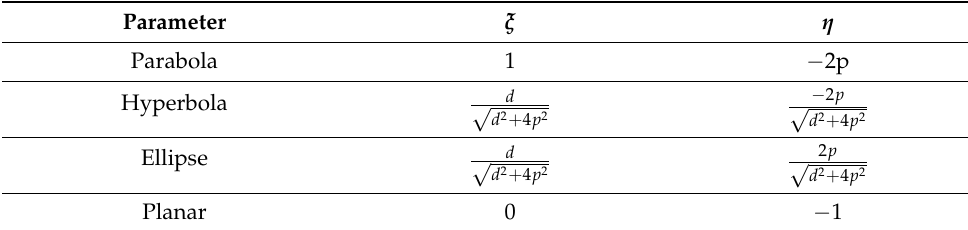
Figure 1. Unit spherical model. Table 1. Unified model parameters.